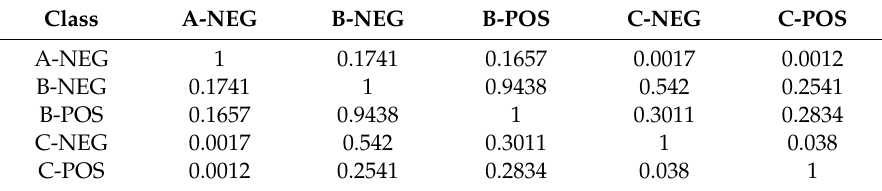
Figure 2. Canonical plot on two dimensions with centroids and individual scores. Canonical variates (Can1 and Can2) were computed from the 5 original variables: percentage of lymphocytes, polymorphonuclear leukocytes (PMN), macrophages and recorded farm parameters milk electrical conductivity (MEC) and average milk flow rate (MFR) selected in the discriminant analysis. The green circles represent the centroids for each class. Table 5. Mahalanobis distance ( p- value) among different classes of milk.